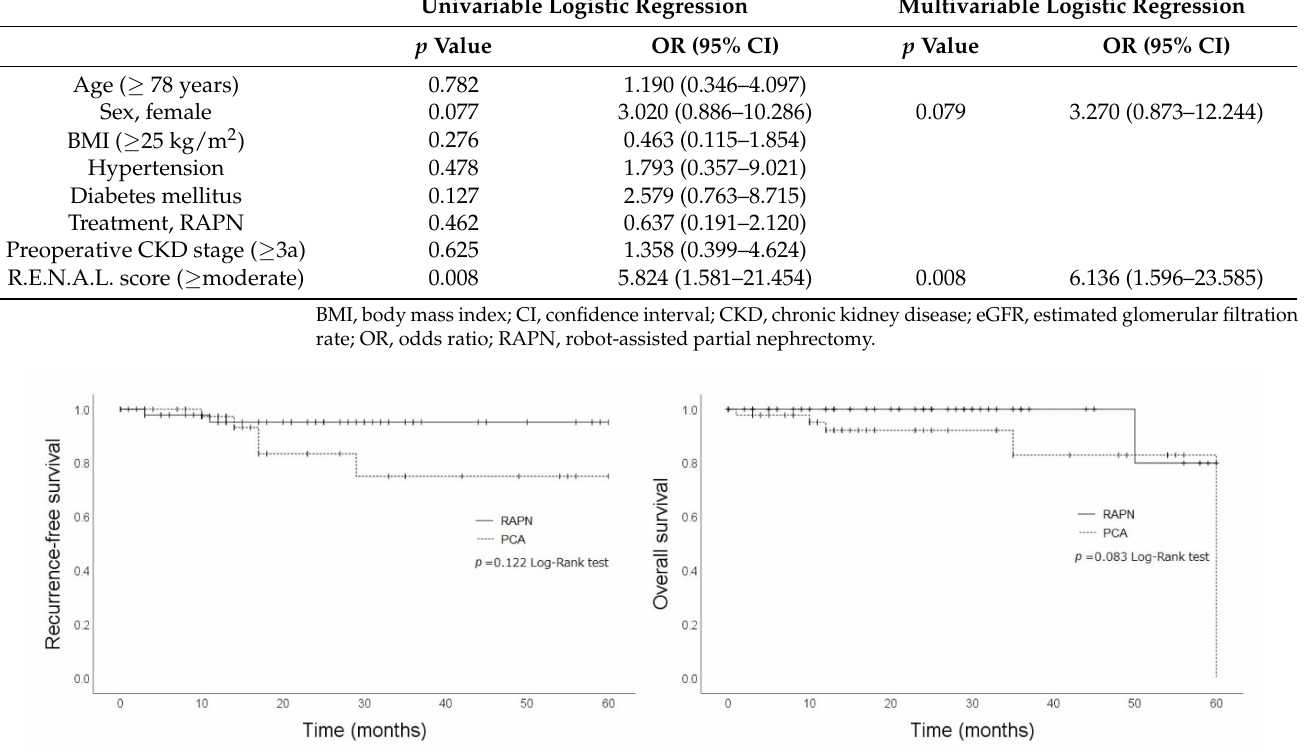
Figure 2. Recurrence-free survival and overall survival. Comparison of recurrence-free survival and overall survival between patients who had undergone robot-assisted partial nephrectomy (RAPN) and those who had undergone percutaneous cryoablation